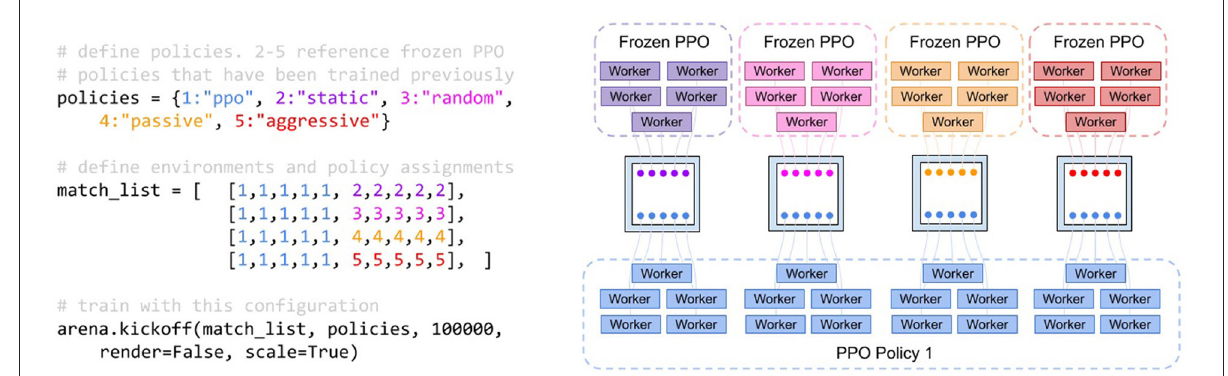
FIGURE4 Pseudo-code and process diagram for the TanksWorld training scheme. The training scheme was used by both the static and dynamic curriculum. (Left) Pseudo-code of the training scheme against multiple policies. “ppo” refers to a PPO (Schulman et al., 2017) policy that is being trained, while the other policies refer to custom frozen policies. (Right) The resulting processes and their organization. Four environments are created, each housing 10 entities. The agents in the competition are depicted as nodes and colored based on the policies that they follow. All blue tanks are contributing to a single policy.